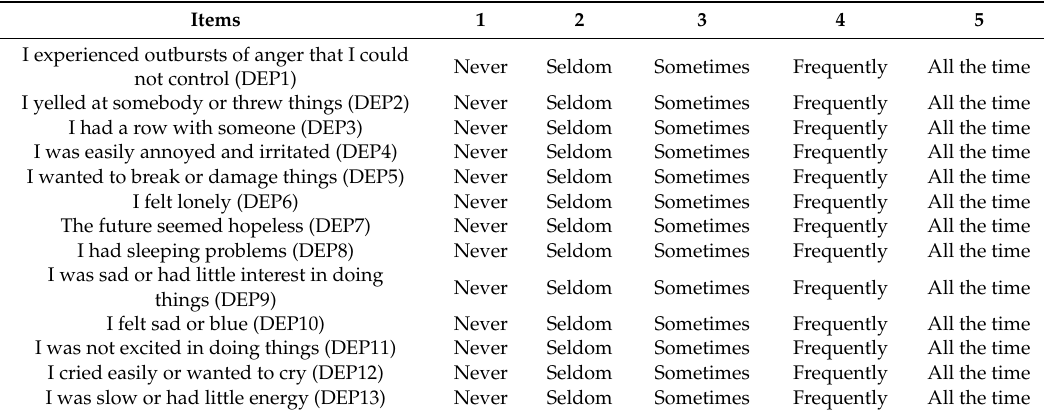
Table A1. Scale to measure depression of the public.